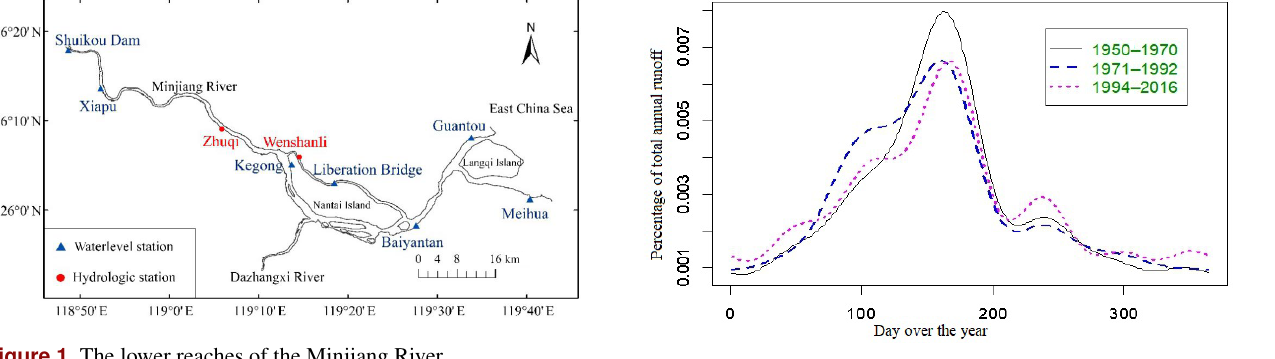
Figure 2. Variation of average daily discharge during three different periods since